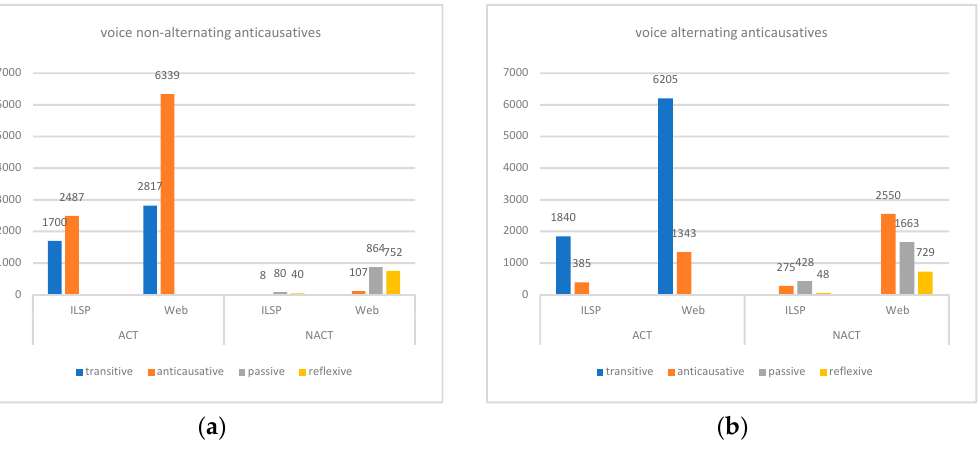
Figure 1. The distribution of verb readings in (N)ACT voice morphology per verb class in written (ILSP) and quasi-oral speech (Web): ( a ) ‘voice non-alternating’ anticausatives; ( b ) ‘voice alternating’